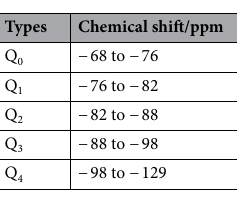
Table 4. Range of 29 Si NMR chemical shifts of Q n structural units in silicate.